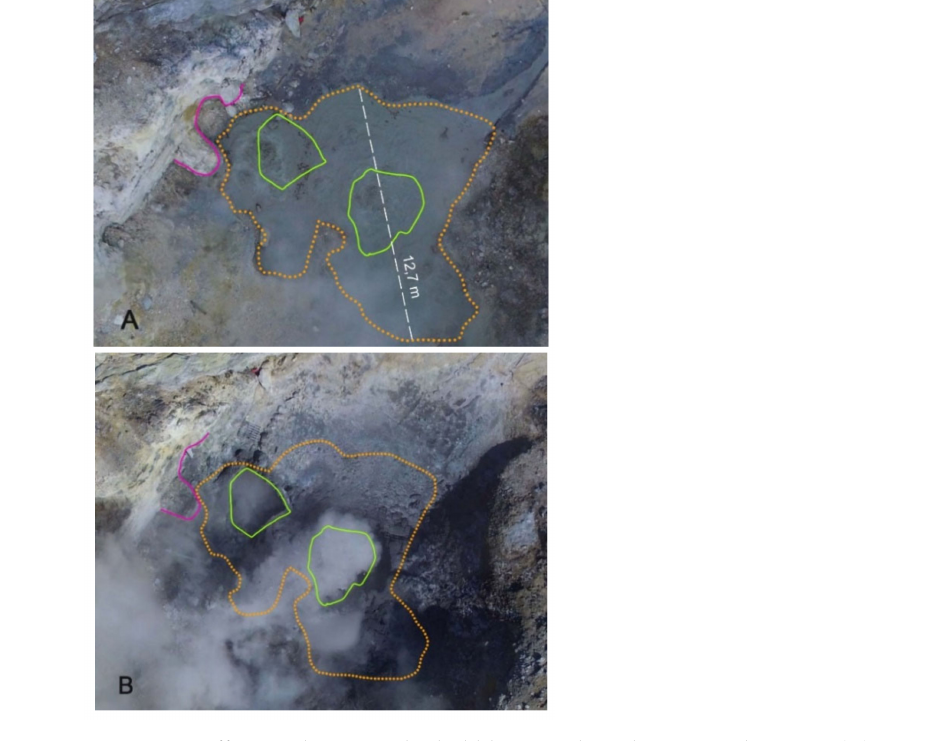
Figure 9. Difference between the bubbling mud pool in December 2019 ( A ) compared with in